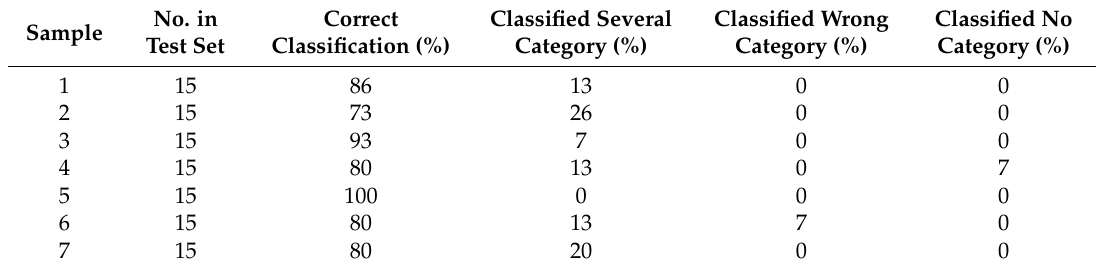
Table 3. Soft independent modeling of class analogy (SIMCA) classification results ( α = 0.05).